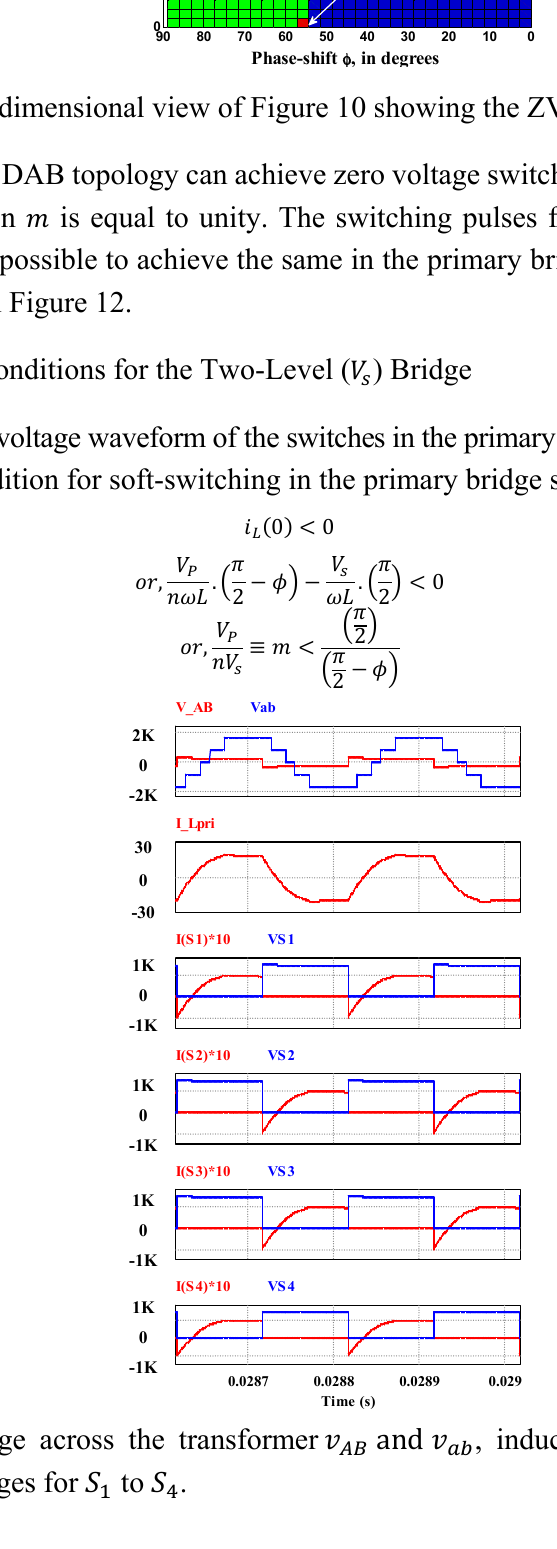
to (cid:1845) (cid:2869) (cid:2872)